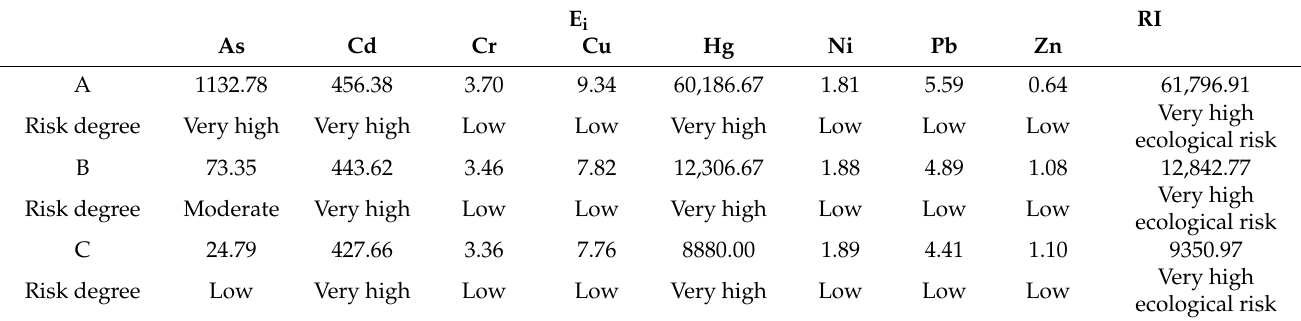
Table 10. Calculation results of the potential ecological risk index.